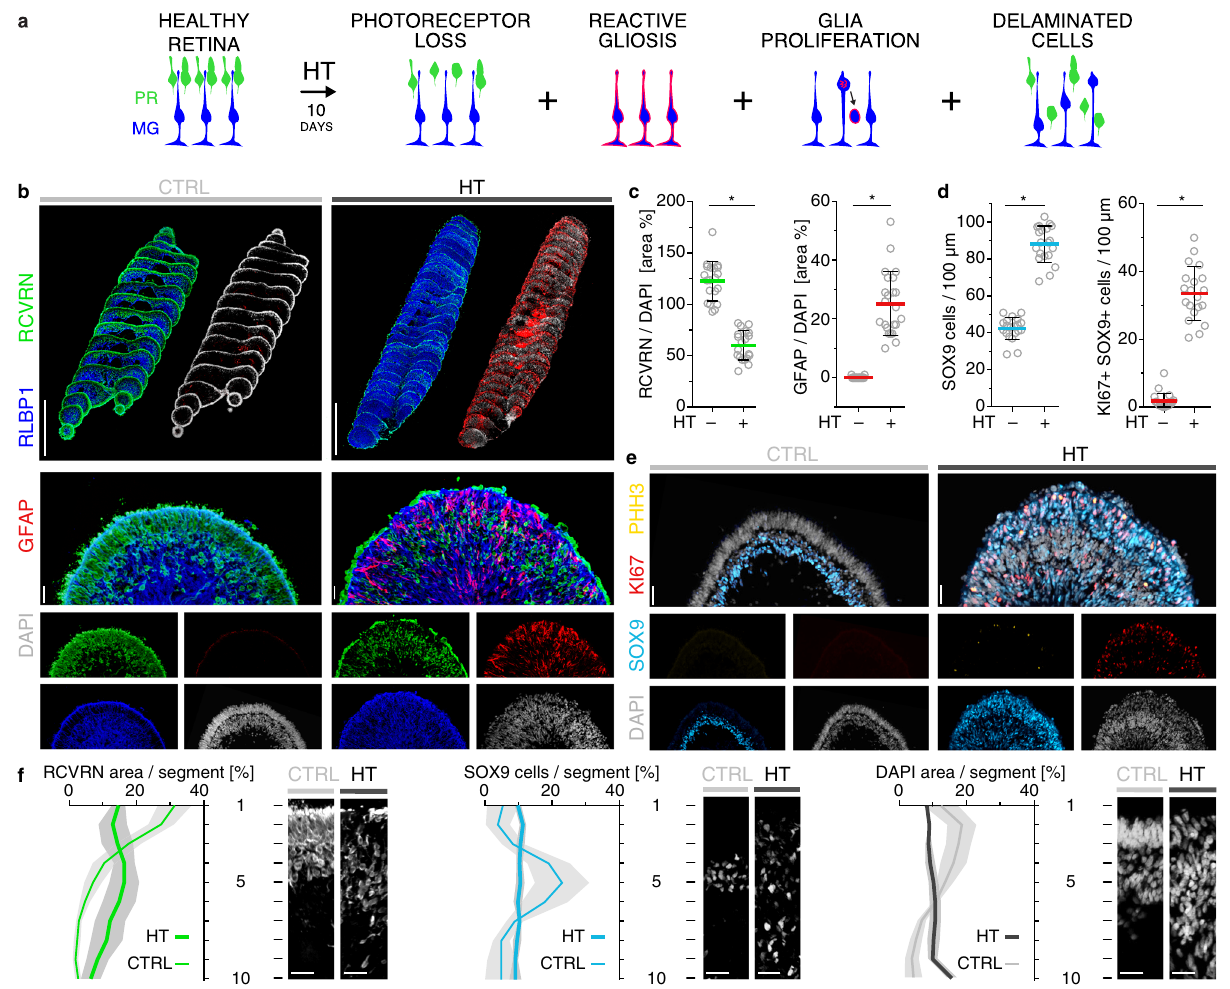
Fig. 4 | HBEGF-TNF induces reactive gliosis, glial proliferation, and retinal dyslamination in HRO. a Schematic of photoreceptor and glial pathologic chan- ges(10-daysHBEGF-TNF(HT)treatment). b – e ImmunostainedserialHROsections were used to quantify the level of gliosis (GFAP) aswell as the photoreceptor cells (RCVRN), Müller glia (RLBP1/SLC1A3 costain), cell nuclei (DAPI) based on marker area analysis, and proliferating (KI67), mitotic (PHH3, phosphohistone H3), and SOX9-positive (Müller glia) cells based on cell counts. Graphs: circles show